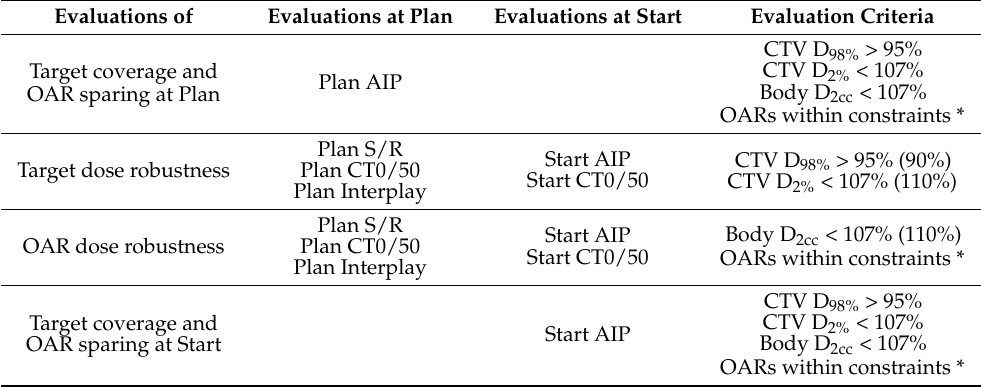
Table A2. Overview of the performed robustness evaluations, and the criteria used in each evaluation. The criteria in parentheses were used for interplay evaluation. * OAR constraints are shown in Table A1.